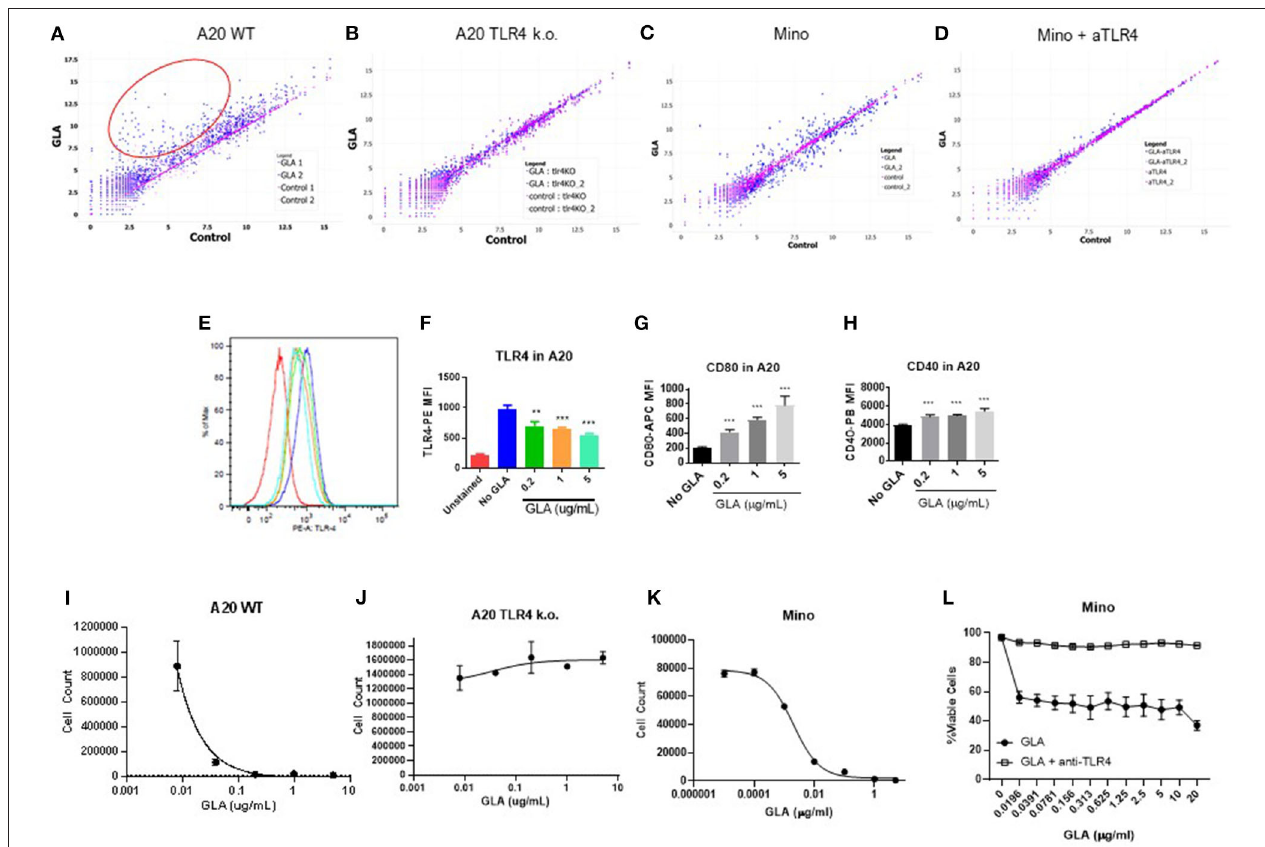
FIGURE 5 | GLA has direct effects on murine and human lymphoma cells by inducing activation and cell death. (A–D) Scatter plot of gene expression analysis in murine or human lymphoma cells. Each dot represents the expression level of a particular gene in the control group (x-axis) or GLA-treated (y-axis) group. The full list of genes with differential expression is available in Supplementary Tables 2–5 . (A,B) A20 WT or TLR4k.o. cells were treated with GLA-AF (5 µ g/mL, 48h) before gene expression analysis by Nanostring using the mouse panCancer immune profiling panel. (A) Scatter plot of gene expression levels in GLA- or control PBS- treated WT A20 cells. (B) Scatter plot of gene expression levels in GLA- or PBS- treated TLR4k.o. A20 cells. The red circle marks genes that are significantly induced by GLA treatment. Two independent samples are included in each treatment group. (C) Mino lymphoma cells were treated with GLA-AF (5 µ g/mL, 48h) before gene expression analysis by Nanostring using the human panCancer immune profiling panel. (D) TLR4 was blocked by adding anti-TLR4 mAb (10 µ g/mL) 15min before GLA treatment and gene expression analysis. (E–H) Direct effects of GLA in A20 tumor cells in vitro . A20 tumor cells were treated with GLA (0.2, 1, or 5 µ g/ml GLA-AF, 48h) before staining with anti-TLR4/MD2, anti-CD80, or anti-CD40. Shown are overlay histogram of TLR4 staining in A20 cells (E) , and summary graphs of mean fluorescent intensity (MFI) of TLR4, CD80, and CD40 expression in GLA-treated or control A20 cells (F–H) . Treatment was done in duplicate. Each column indicates mean ± sem of duplicate wells. (I,J) Dose-dependent inhibition of the growth of WT but not TLR4k.o. A20 cells by GLA. The cells were treated with serial dilution of GLA (0.01–5 µ g/mL) for 96h before the cells were stained with Live/Dead-NIR and evaluated by FACS. Shown are mean ± sem of cell numbers in two duplicate treatment wells. (K) Dose-dependent inhibition of the growth of Mino lymphoma cells. The cells were treated with serial dilution of GLA for 96h before the cells were stained with Live/Dead-NIR and evaluated by FACS. (L) The addition of anti-TLR4 mAb blocked the growth inhibitory effects of GLA in Mino cells. ** p < 0.01, *** p <